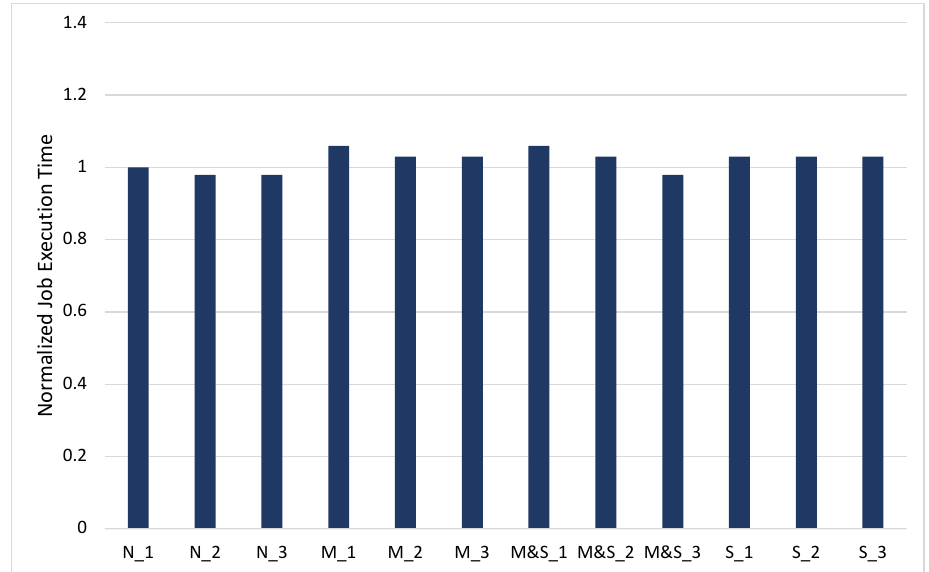
Figure 8. The normalized TeraSort job execution time for 10 GB dataset.